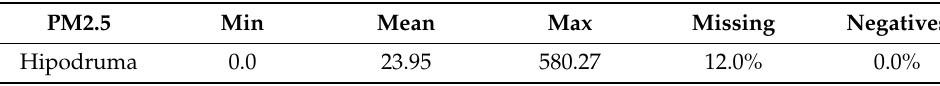
Table 5. Quality of the raw dataset for